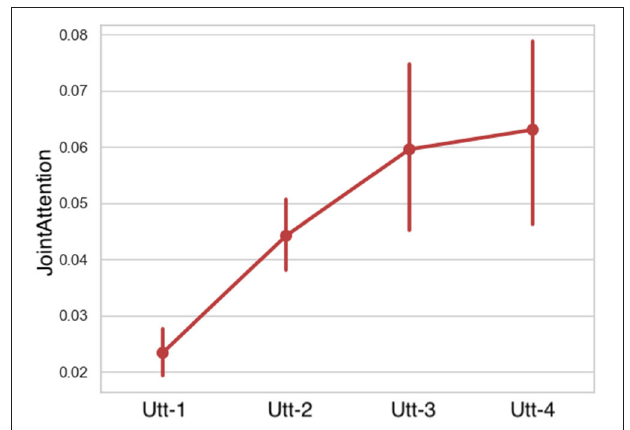
FIGURE 11 | Joint attention among the conversational partners per utterance sequence. Error bars indicate standard error of the